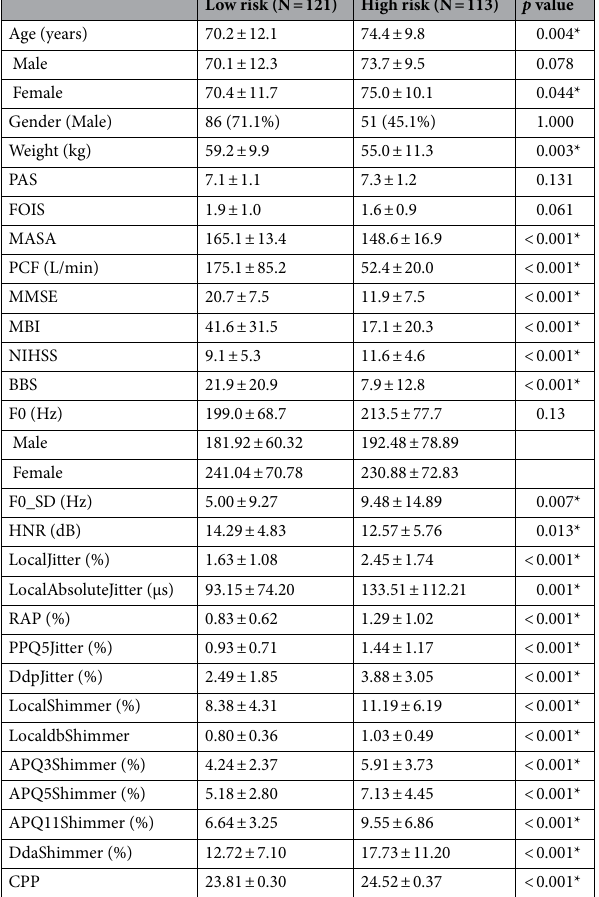
Table 2. Demographic features and acoustic parameters according to respiratory complication risk within those with tube feedings. Values are presented in mean ± standard deviation (SD) or number (%). * p < 0.05 is used for statistical significance. PAS penetration-aspiration scale, FOIS functional oral intake scale, MASA mann assessment of swallowing ability, PCF peak cough flow, MMSE mini-mental state